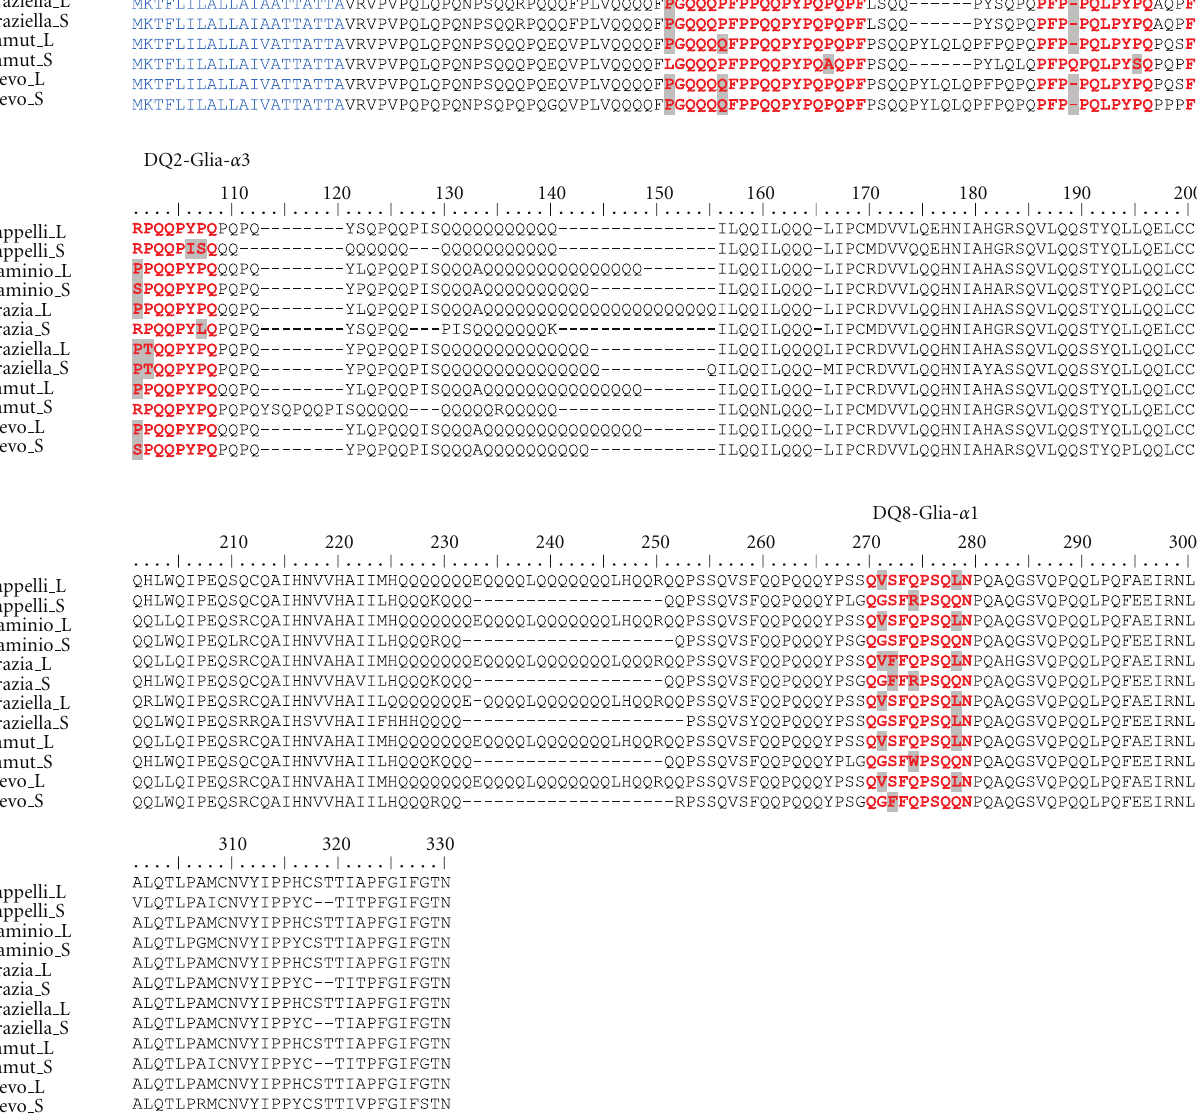
Glia- α 3 (Flaminio, Grazia, Graziella Ra, Kamut and Svevo); (4) a single serine to phenylalanine substitution (S → F) at p 3 (Grazia and Svevo S); a single glutamine to